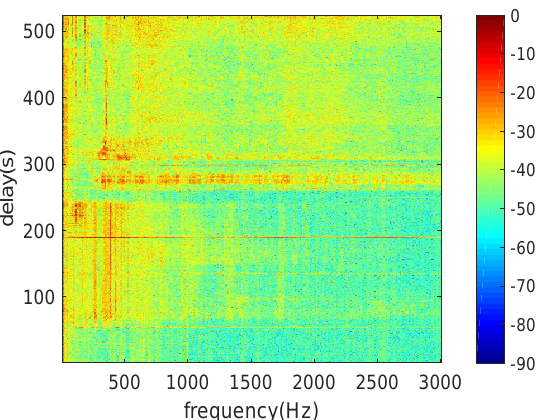
Figure 4. Delay-frequency map of experimental data. (the unit of colorbar is